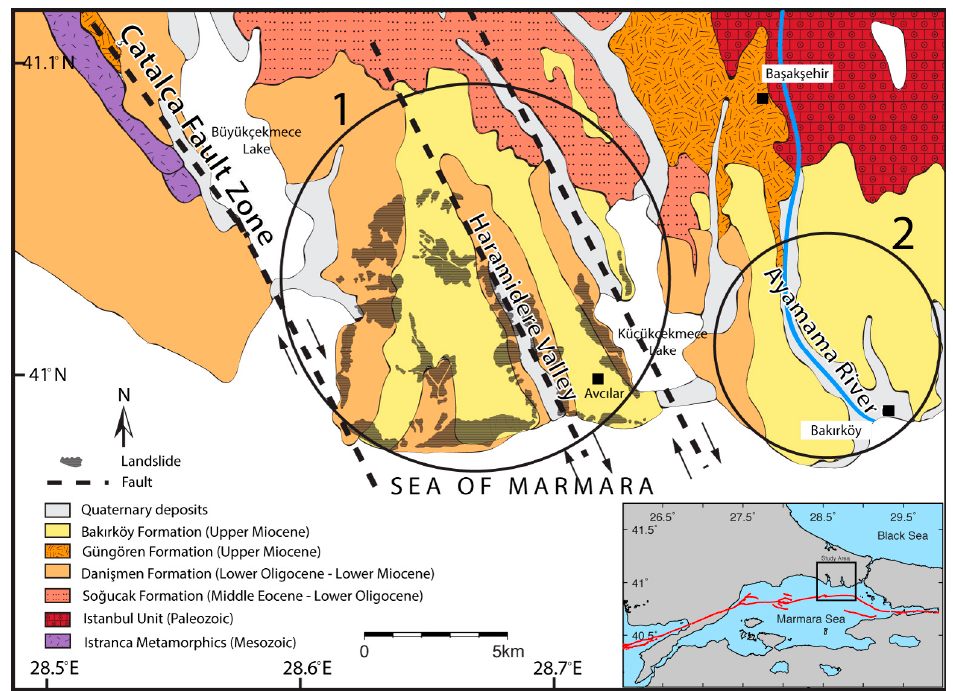
Figure 2. Simplified geological and structural map of study areas 1 and 2 (circles 1 and 2 as in Figure 1). Numerous active landslides (dark green patches) were mapped between the Küçükçekmece and Büyükçekmece lakes [simplified from Ergintav et al., Duman et al. and Ozgul et al. [37–39]. The inset map shows a figure area north of the Sea of Marmara, and the main segments of the NAF in red